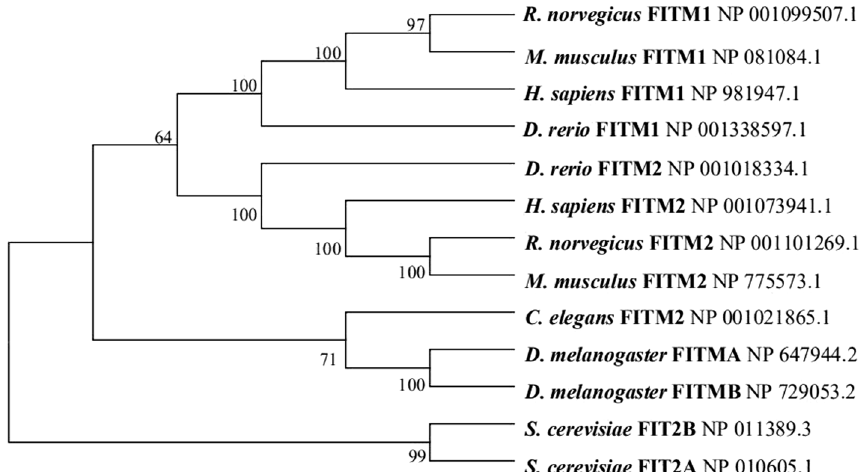
Fig. 1 Sequence alignments of FITM orthologs in multiple model species. Cladogram generated with ClustalW showing the amino acid sequence homologies between FITM proteins. Accession numbers for each FITM protein are indicated next to the